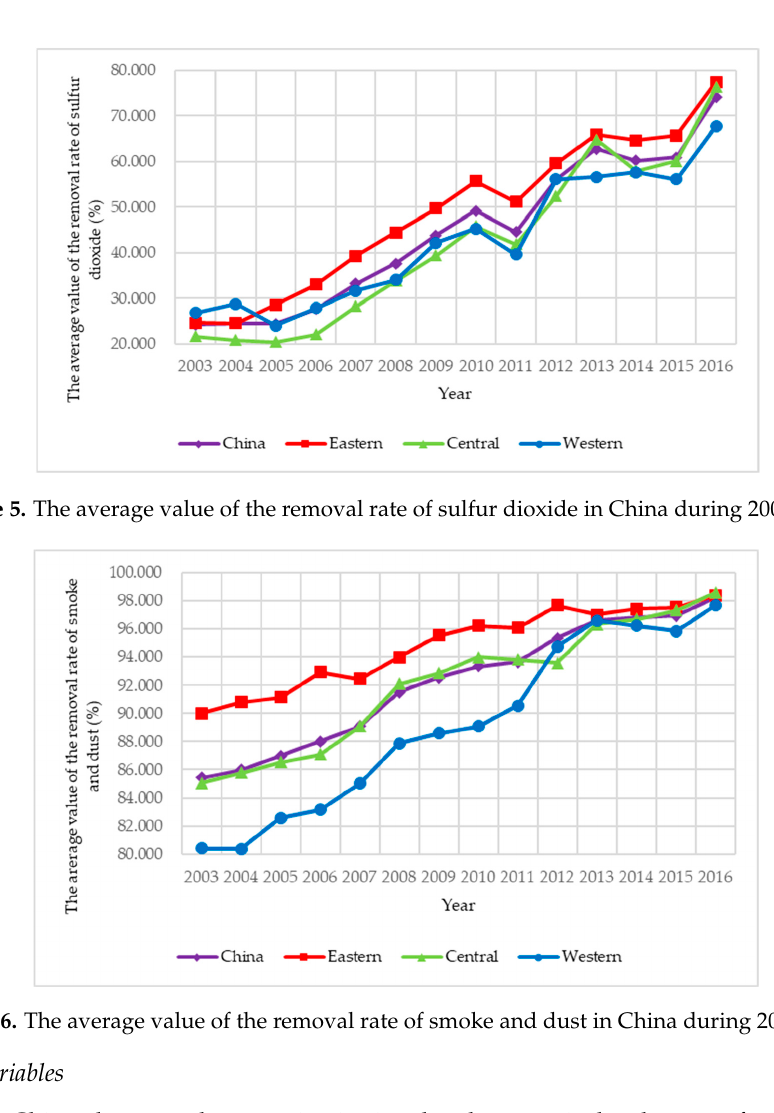
Figure 4. The average value of the emission intensity of smoke and dust in China during 2003–2016.